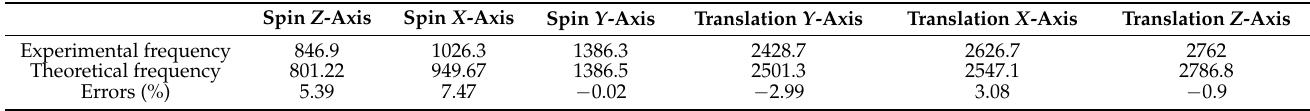
Table 9. Comparison of the theoretical modal frequency and experimental modal frequency (Hz).